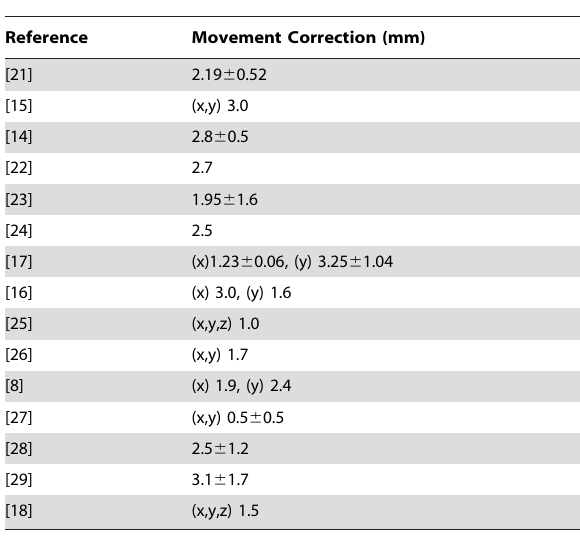
Table 1. Overview of Evaluated Cardiac and Thorax Image Registration Methods